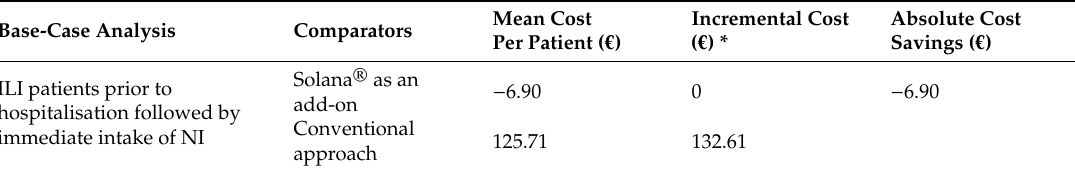
Table 2. Results of the base-case